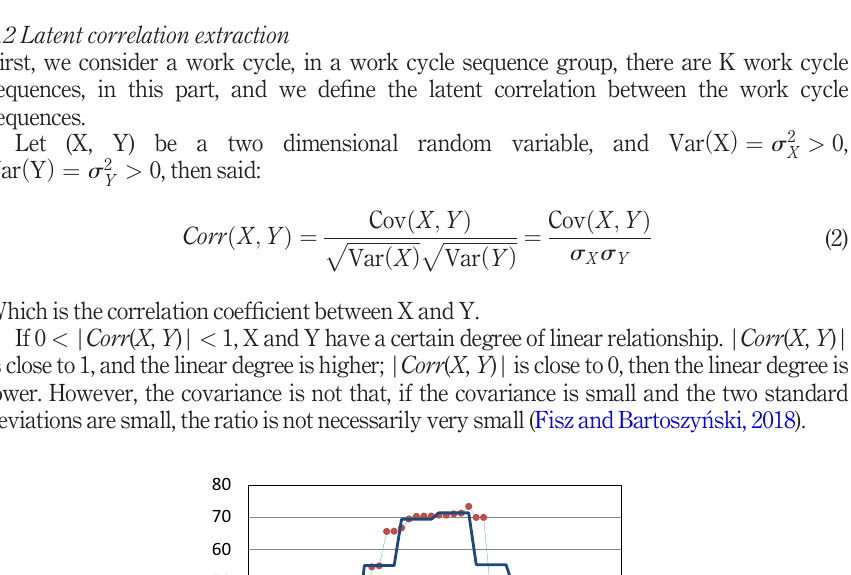
Figure 7. The raw data is represented by the dotted line, the data through the PAA technology to reconstruct is indicated by real lines